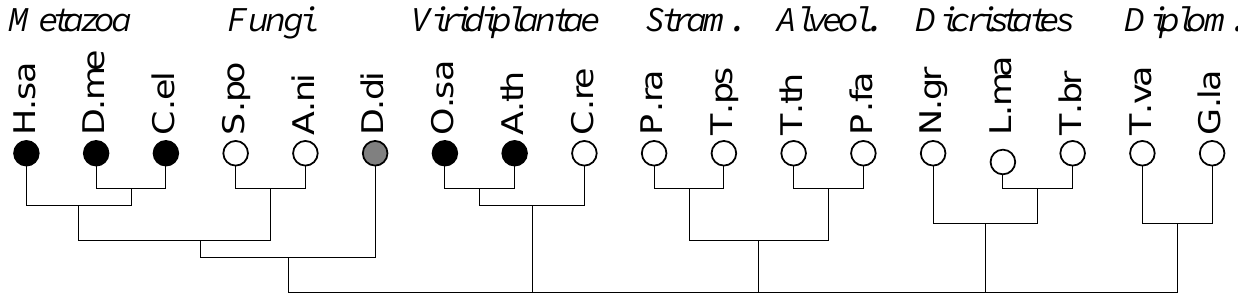
Alveol. Dicristates Diplom.Metazoa Viridiplantae Stram.Fungi